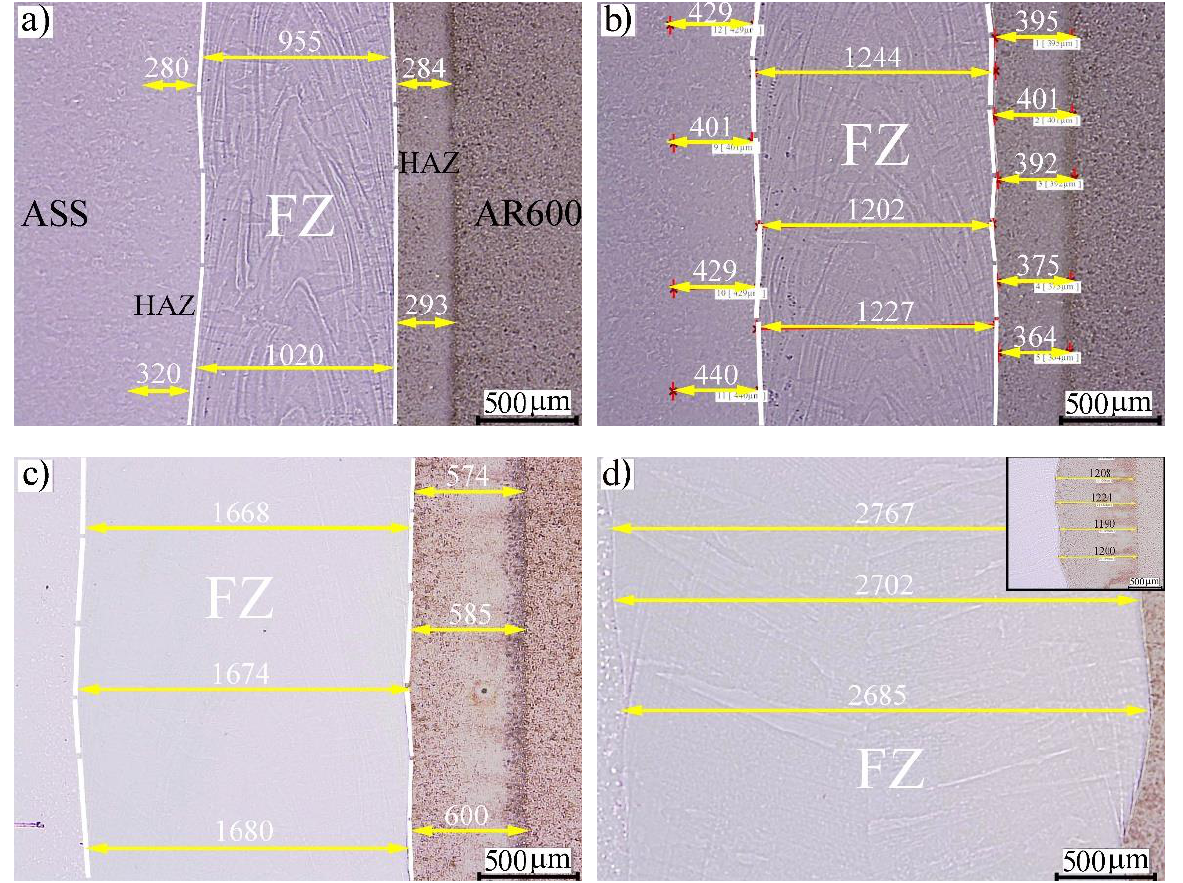
Figure 1. Morphology of welded joints with various EIs: ( a ) 50 J/mm; ( b ) 100 J/mm; ( c ) 160 J/mm; ( d ) 320 J/mm.